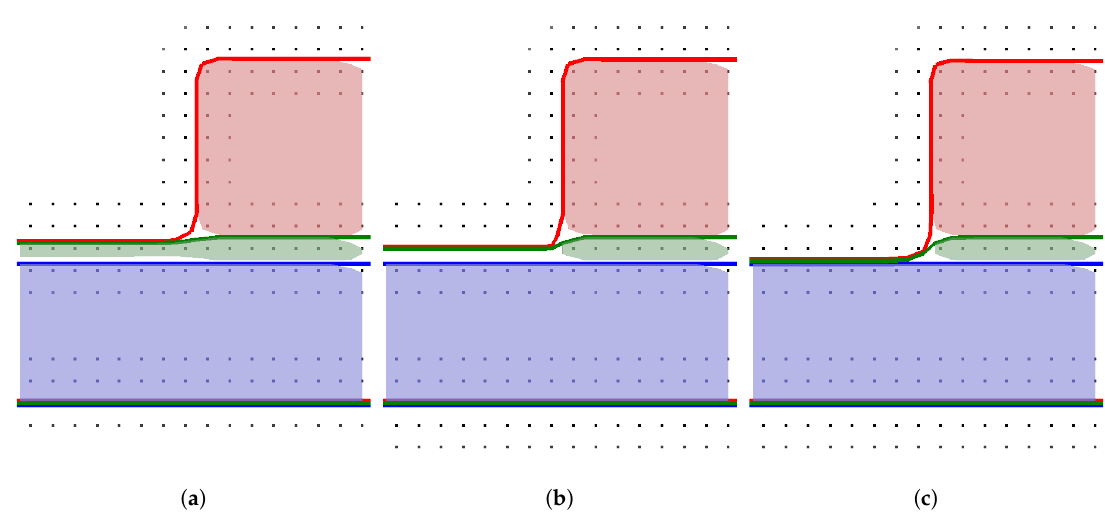
Figure 4. Exemplary development of material stack shown in Figure 3. ( a ) beginning of etching process; ( b ) green layer in sub-grid resolution; ( c ) green layer fully